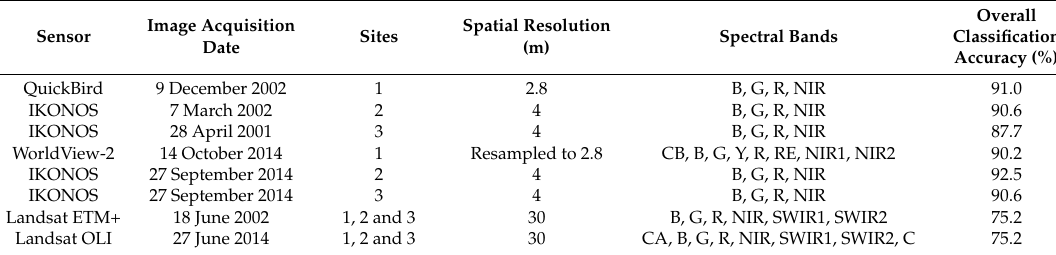
Table 2. Satellite sensor imagery used for generation of land cover maps (spectral band B = blue, C = cirrus, CA = coastal aerosol, CB = coastal blue, G = green, NIR = near infra-red, R = red, RE = red edge, SWIR = short-wave infrared, Y = yellow), land cover classification accuracy, and number of accuracy assessment locations